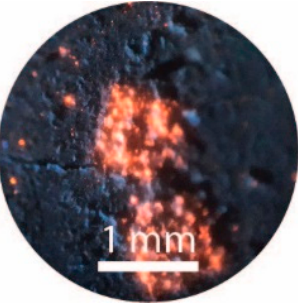
Figure 13. Micro-photograph in cold cathodolumi-nescence (CL) of spodumene + quartz aggregates in the sample 37-B2.